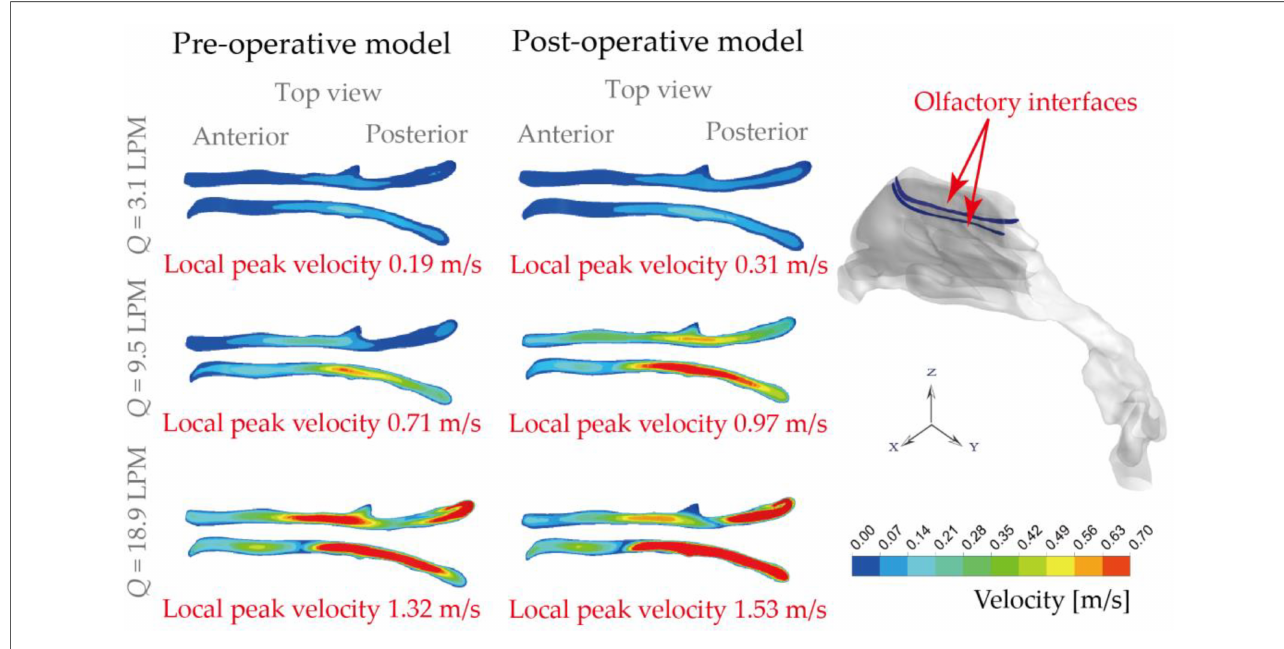
FIGURE 9 Olfactory ventilation comparison based on local velocity distributions at the olfactory interfaces, under inhalation fl ow rate of 3.1 LPM, 9.5 LPM and 18.9